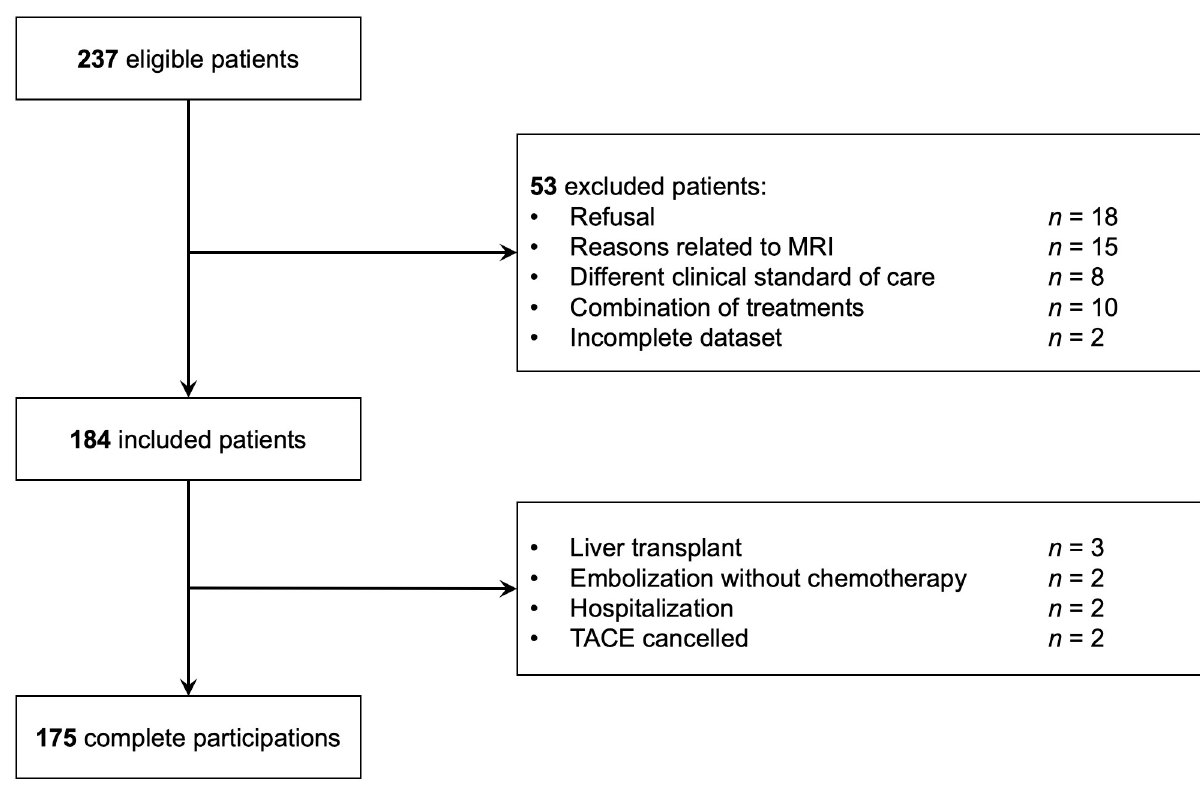
Fig 5. Flowchart of patient